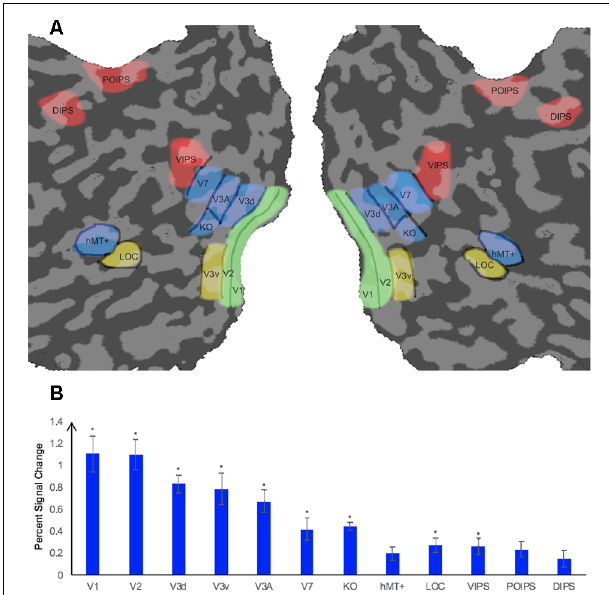
FIGURE 2 | Illustration of a flattened cortical surface with regions of interest (ROIs) superimposed and percent signal change of each ROI. (A) ROIs. The retinotopic areas (V1, V2, V3d, V3v, V3A), higher ventral area (LOC), higher dorsal areas (KO, V7, hMT+), and intraparietal sulcus (IPS) areas [dorsal intraparietal sulcus (DIPS), parieto-occipital intraparietal sulcus (POIPS), ventral intraparietal sulcus (VIPS)]. Sulci are indicated in dark gray whereas gyri are indicated in light gray. ROIs were defined by standard localizers in separate sessions (see the “fMRI Data Acquisition” section). (B) Percent signal change of each ROI. Error bars represent standard error of the mean across participants ( n = 8). Asterisks indicate that the percent signal change is significantly greater than 0, as assessed by a t -test of group data ( ∗ p ≤